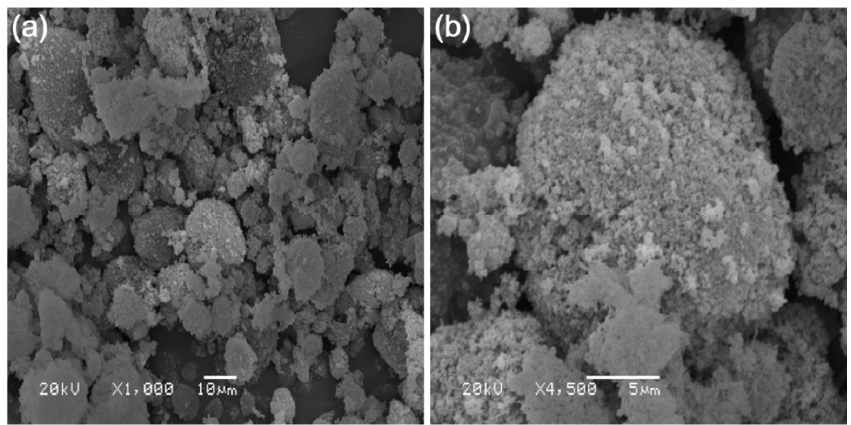
Figure 2. Scanning Electron Microscope SEM images of nano-SiO 2 ( a ) amplification factor of 1000; ( b ) amplification factor of 4500. Table 2. Basic properties of nano-SiO 2 used in this study.